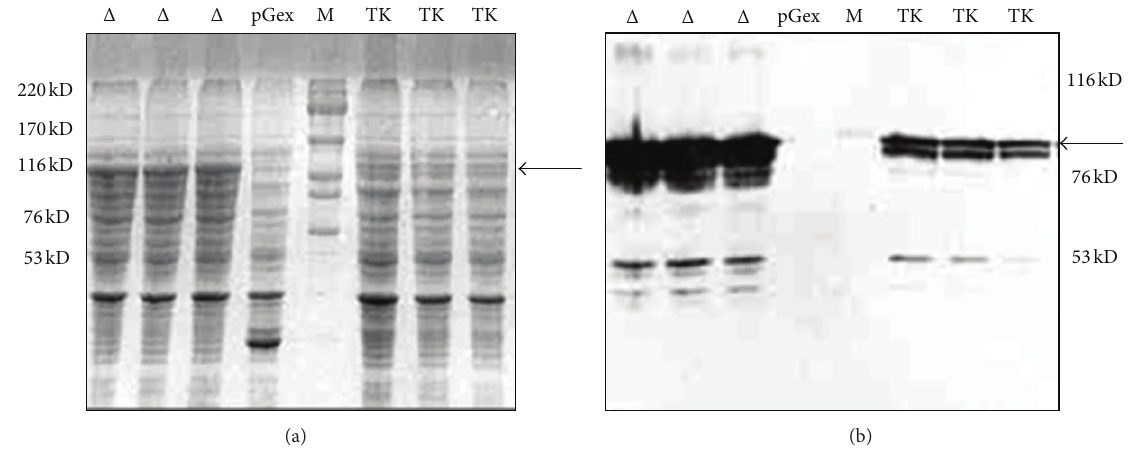
Figure 1: GST-TKJM and GST-TKJM Δ expression in E. coli. E. coli were transformed with the pGEX-TKJM ( TK ), pGEX-TKJM Δ ( Δ ), and the pGEX-6-P-1 (empty) plasmids, and the recombinant proteins are expressed as indicated in Section 2. The proteins were run in a 10% SDS-PAGE and stained with Coomassie blue (a) or subjected to western blot using an anti-GST antibody (b). Several E. coli clones expressing TKJM (TK) or TKJM Δ ( Δ ) are shown. The arrow points to the TKJM and TKJM Δ recombinant proteins.